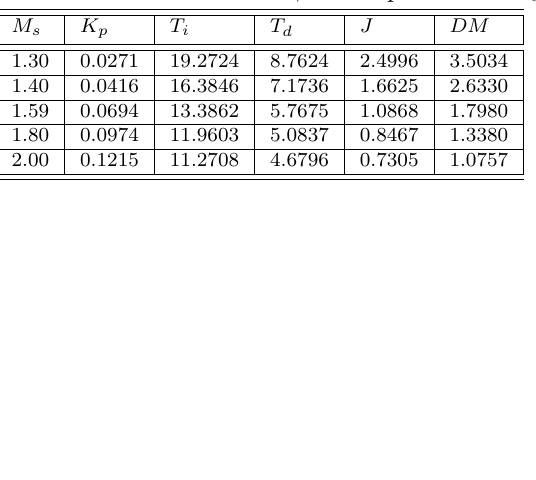
Table 7: POI-PID controllers, with a prescribed M s .